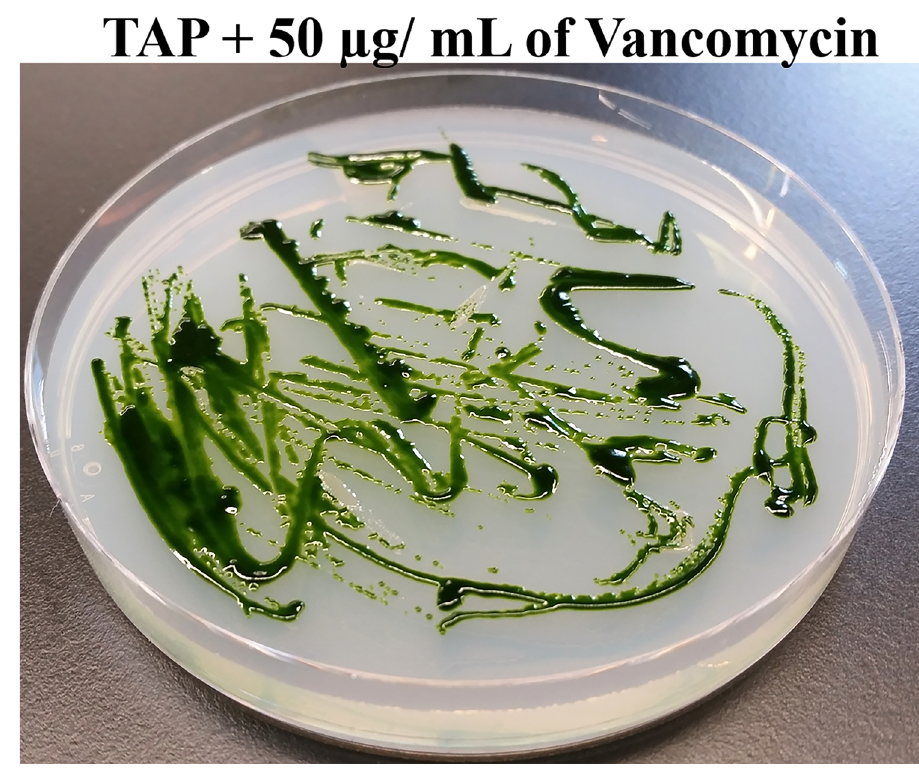
Figure 2. Testing the efficacy of Vancomycin in eliminating Clip185 contamination. Chlamydomonas wild type 4A+ and Clip185 strains were streaked on TAP-agar plate containing 50 μ g of Vancomycin/mL of medium. TAP-agar antibiotic plate was incubated at room temperature (22 ° C) for 2.5 weeks before it was